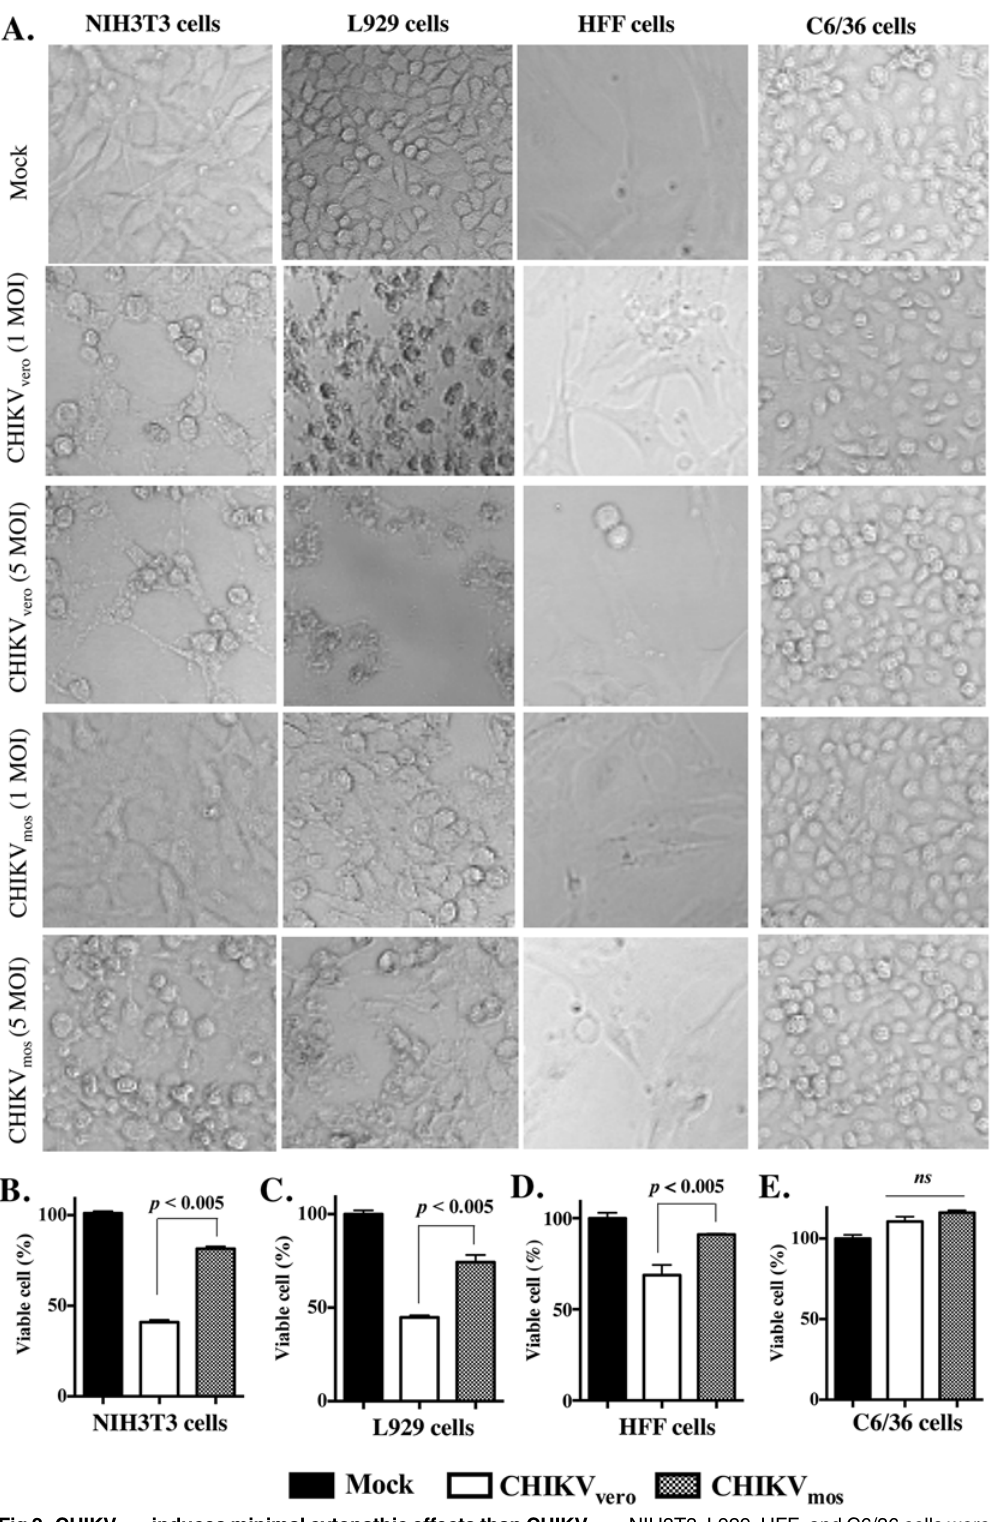
Fig 2. CHIKV mos induces minimal cytopathic effects than CHIKV vero . NIH3T3, L929, HFF, and C6/36 cells were infected with CHIKV mos or CHIKV vero (Ross strain, MOI as indicated) for 48 h and fixed with 4% PFA after removing culture medium. (A) Phase contrast images (100X) were acquired using a Zeiss LSM510 META microscope. The cell viability data of NIH3T3 (B), L929 (C), HFF (D) and C6/36 (E) cells infected with CHIKV mos or CHIKV vero (Ross